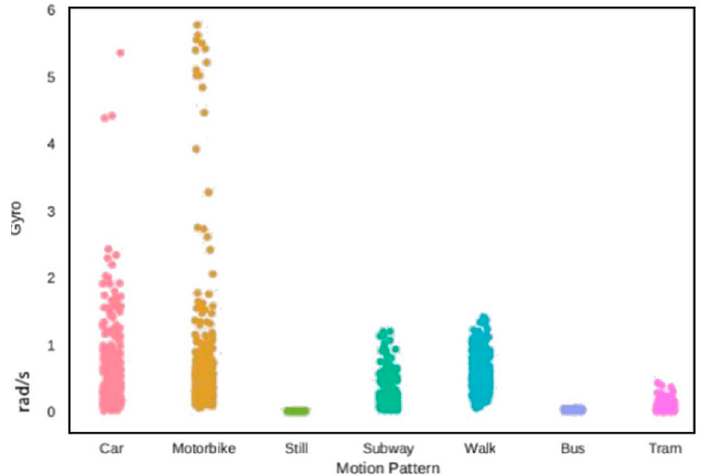
Figure 3. Module of the angular speed vector for the various transportation modes, during one sampling time.